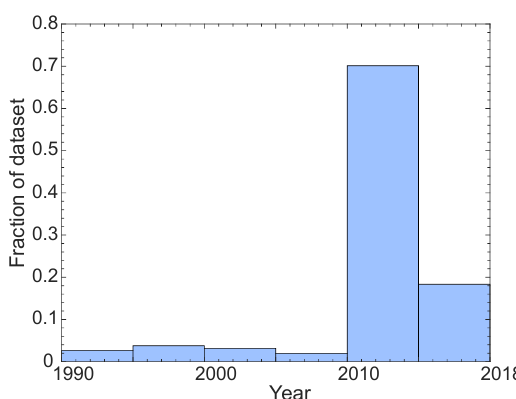
Figure 7. Histogram showing the fraction of snow depth on sea ice measurements by